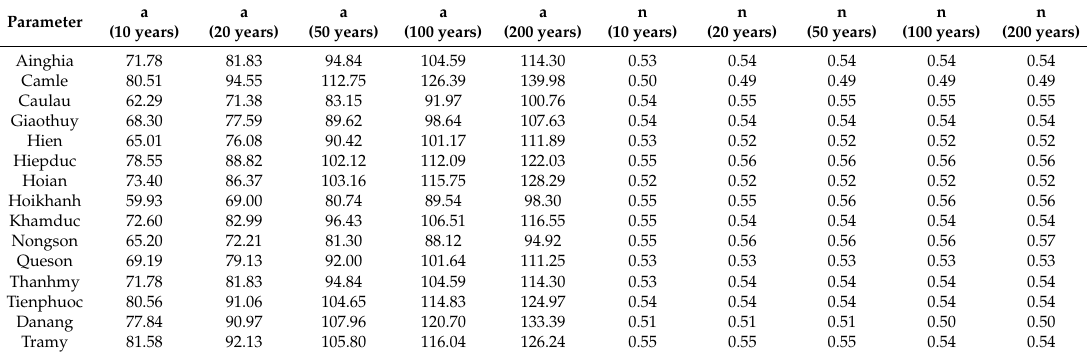
Table 4. Parameters a and n for various return periods (years) for the gauging stations in VG-TB basin. Parameter